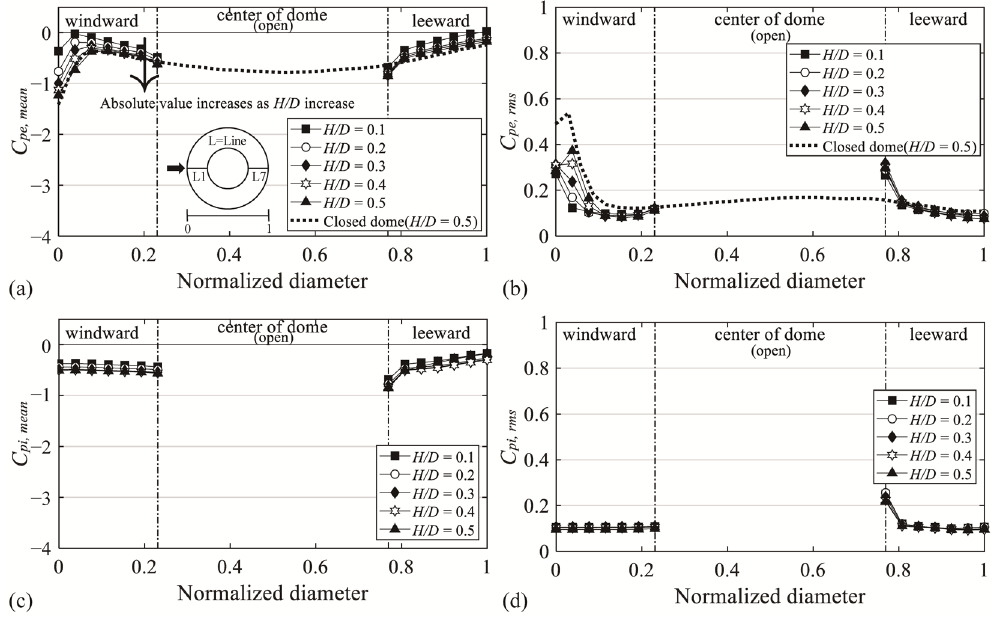
Figure 5. Variation of mean and fluctuating pressure coefficient depending on H/D : ( a ) C pe,mean , ( b ) C pe,rms , ( c ) C pi,mean , and ( d ) C pi,rms .